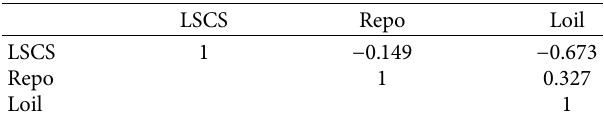
Figure 2: The flowchart of the MODWT with ANFIS. Table 2: The correlations between the input and the output variables.